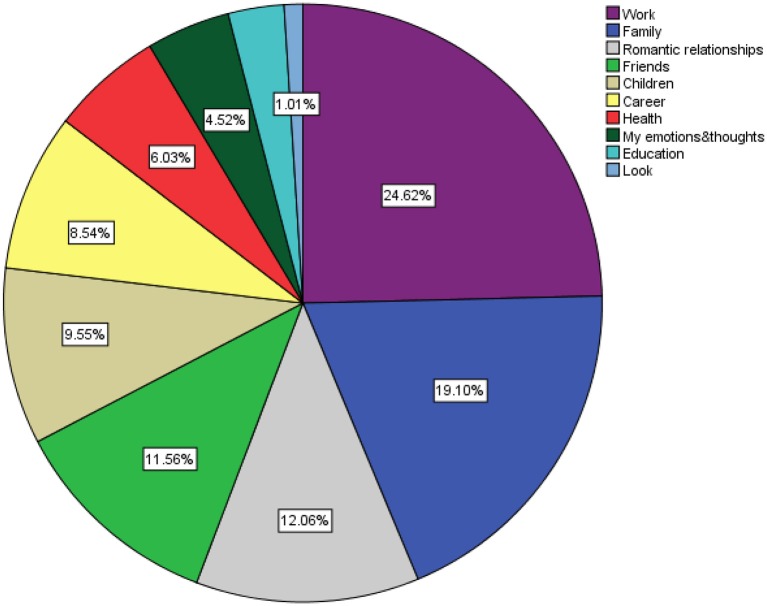
Life domains users reported feeling distress about.